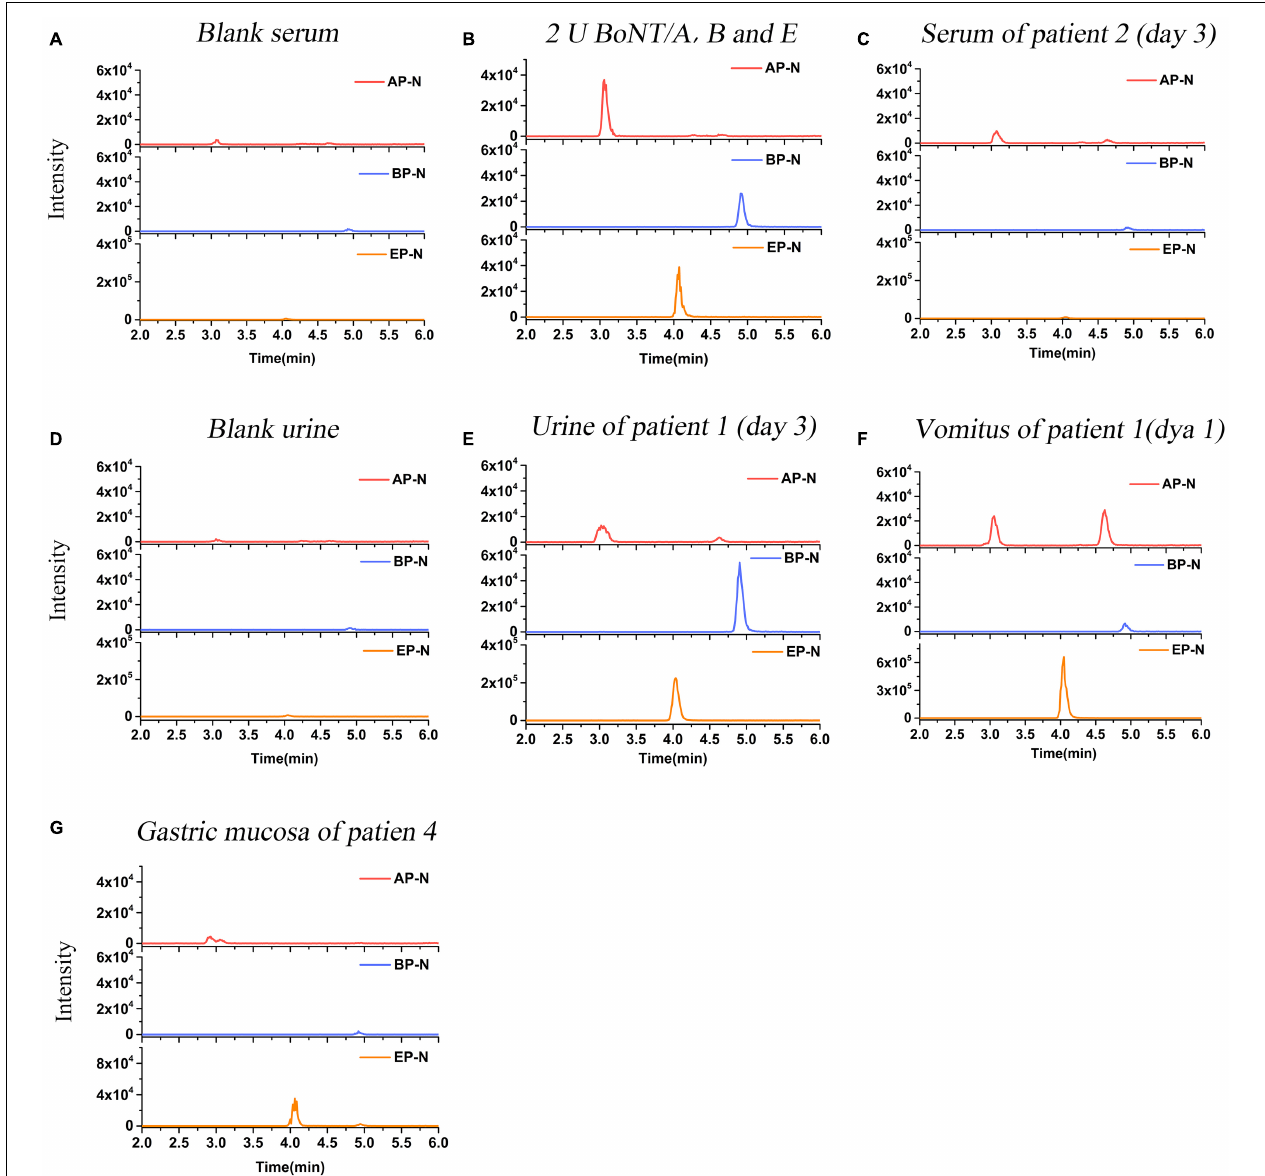
FIGURE 4 | LC-MS/MS (MRM) peak intensities for N-terminal products of BoNT/A, B, and E in clinical samples. (A) N-terminal products obtained in blank serum. (B) N-terminal products obtained in serum spiked with 2 U BoNT/A, B, and E (positive control). (C) N-terminal products obtained in serum samples of Patient 2 on day 3 after the symptom onset. The results showed serum of Patient 2 was positive for BoNT/A, and negative for BoNT/B and E. (D) N-terminal products obtained in blank urine. (E) N-terminal products obtained in urine samples of Patient 1 on day 3. The results showed urine was positive for BoNT/A, B, and E simultaneously. (F) N-terminal products obtained in the vomitus sample of Patient 1 on day 1. The results showed the vomitus sample was positive for BoNT/A, B, and E simultaneously. (G) N-terminal products obtained in the gastric mucosa sample of Patient 4. The results showed the sample was positive for BoNT/E, and negative for BoNT/A and